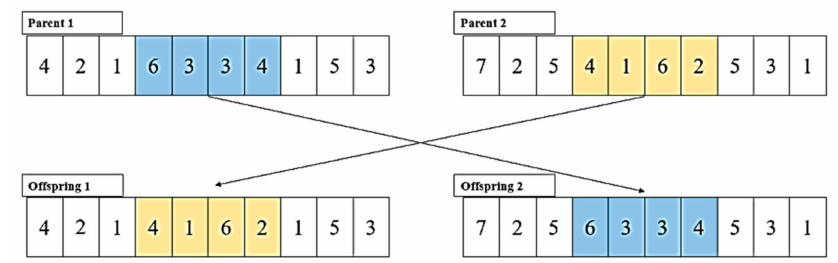
Figure 6. A two-point